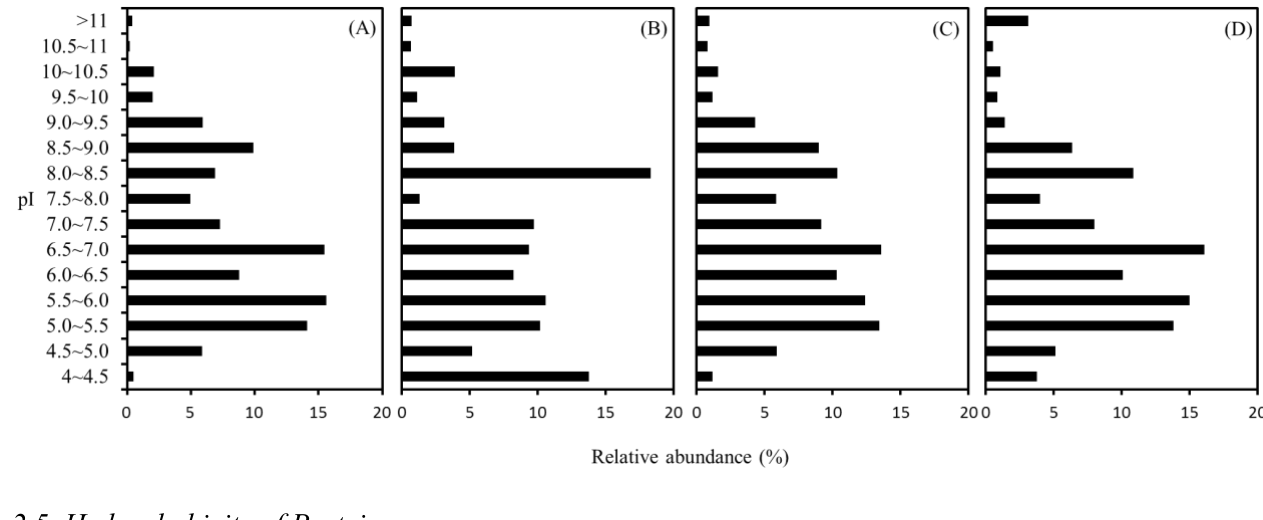
Figure 4. Distribution of isoelectric point (pI) of the identified proteins extracted with SDS ( A ); Triton ( B ); CHAPS ( C ); and RIPA ( D ) buffers.